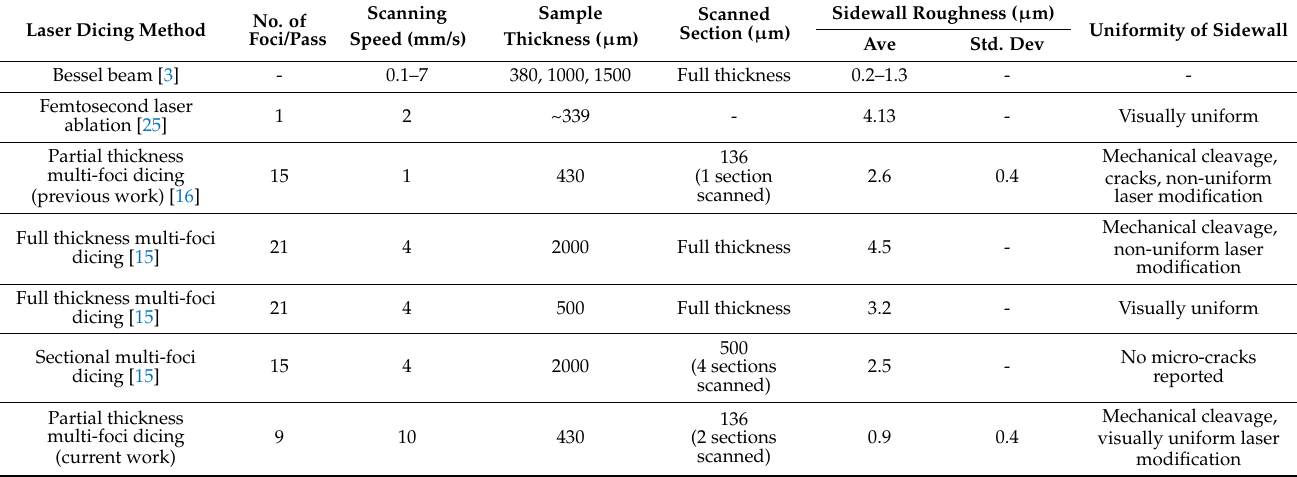
Table 4. Comparison of sidewall roughness of cleaved sapphire samples by various laser dicing methods.